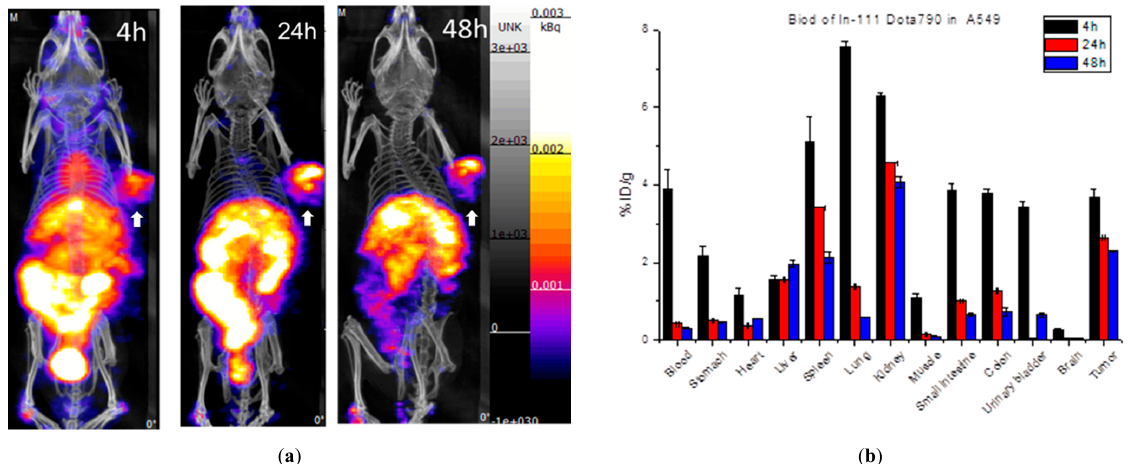
Figure 5. ( a ) SPECT/CT images and ( b ) biodistribution of 111 In-DOTA-NIR790 in mice bearing subcutaneous CT-26 colon cancer ( n = 3 at each time point). Arrow indicates tumor.